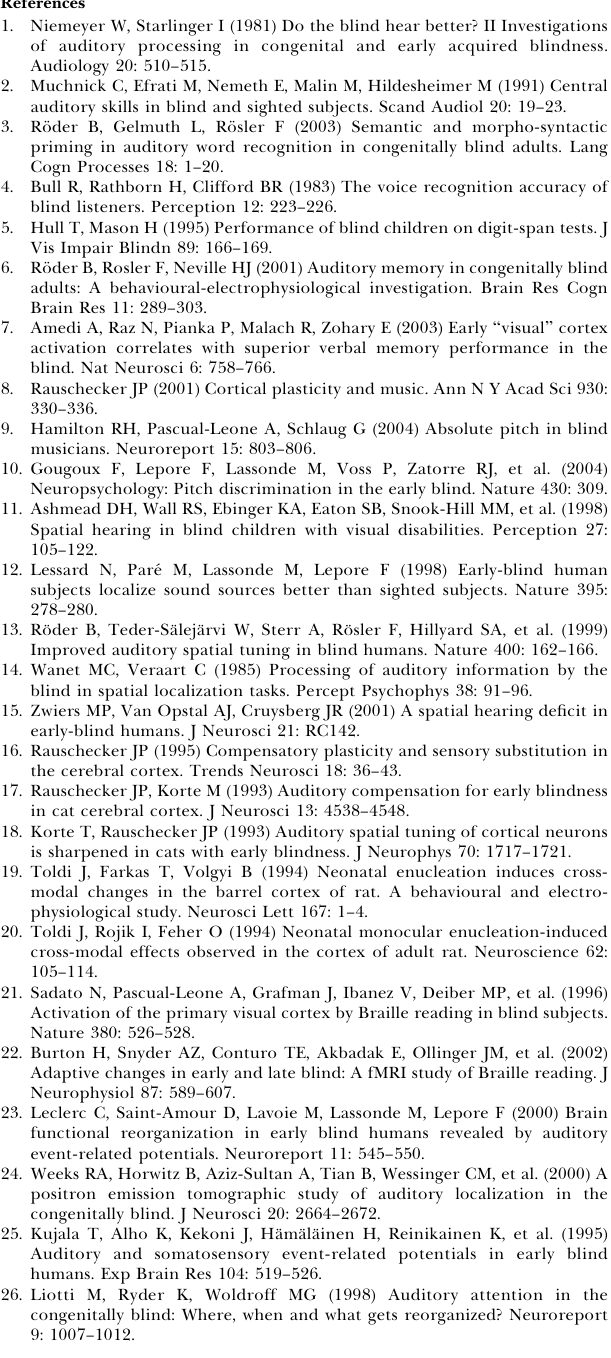
Table S1. Stereotaxic Coordinates and t Values of Activation and Deactivation